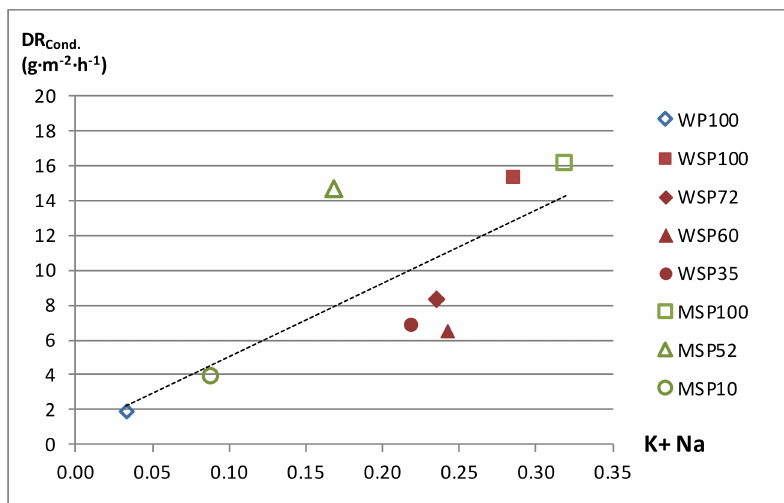
Figure 7. Deposition rate by condensation versus K + Na (mol/kg fuel ).